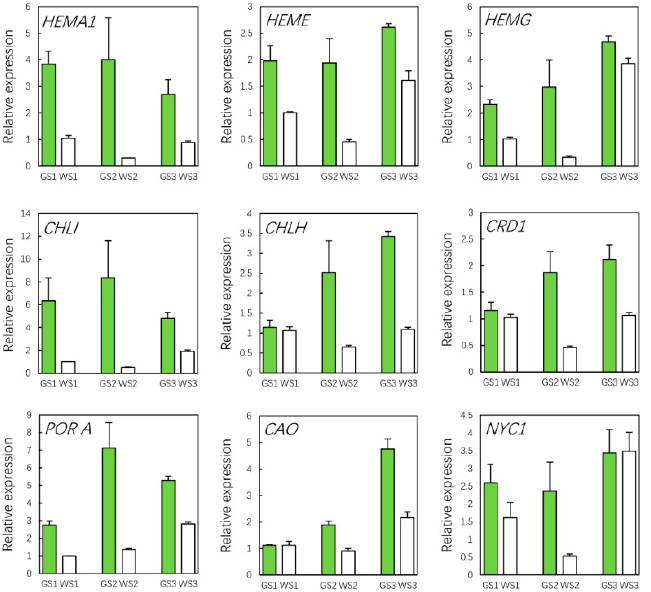
Figure 5. qRT-PCR analysis of DEGs involved in chlorophyll metabolism in different samples.